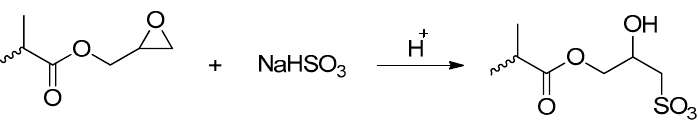
Scheme 1. Sulfonation reaction of GMA.